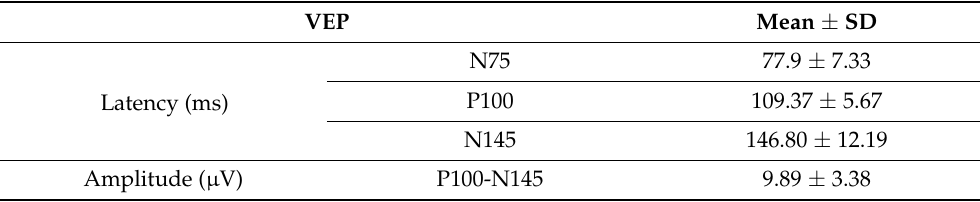
Table 3. Visual evoked potentials in the study group after 6